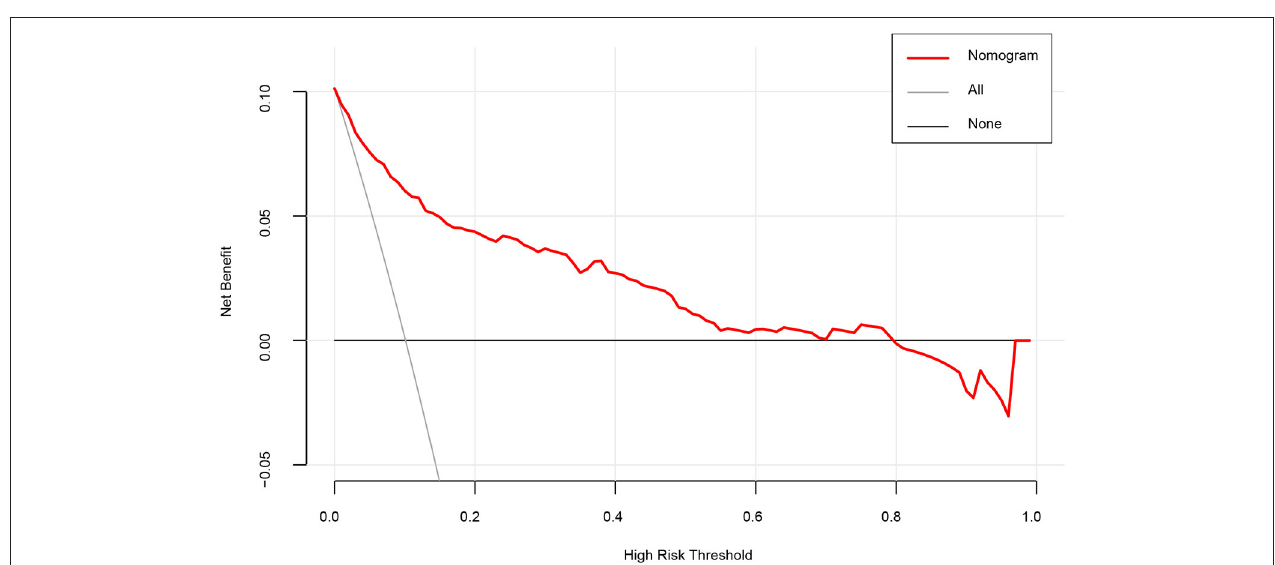
FIGURE 4 | A decision curve analysis (DCA) for the nomogram model to predict stroke. The x -axis indicates the threshold probability and the y -axis indicates the net benefit. The thick black line represents the net benefit when assume that no patient suffering stroke. The thin gray line shows the net benefit when assume that all patients suffering stroke. As shown by the red curve in the figure, when the threshold probability is < 0.79, using our nomogram prediction model yields significant net clinical benefits to patients.